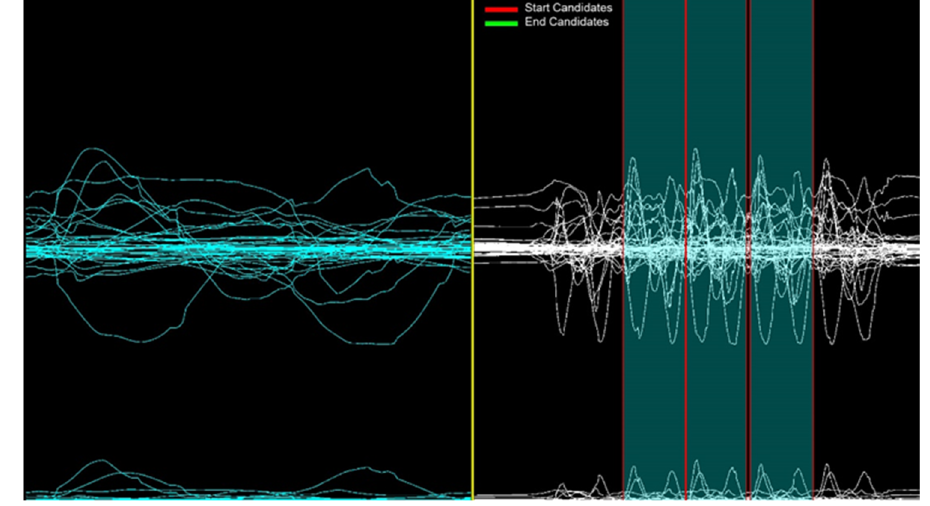
Figure 5. The result with a slice count of 10.